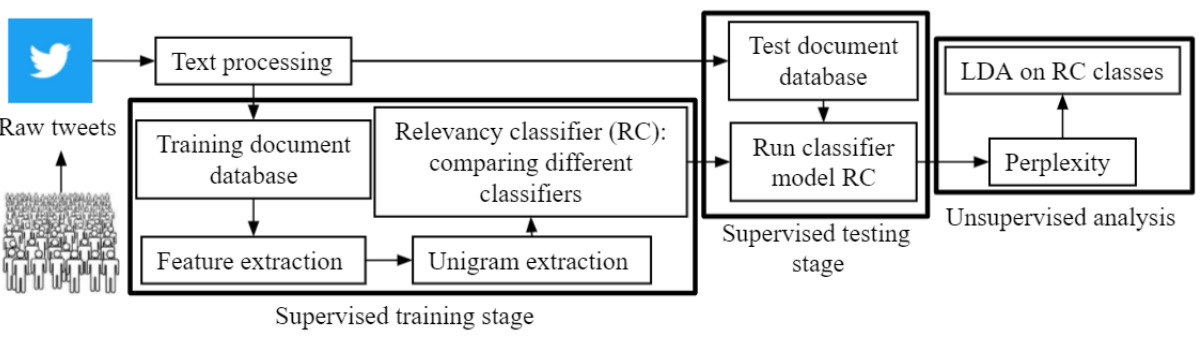
Figure 1. Methods for a hierarchical supervised classification technique. Large black boxes indicate where supervised machine learning algorithms were trained, supervised machine learning algorithms were tested, and where unsupervised machine learning algorithms were used. LDA: Latent Dirichlet